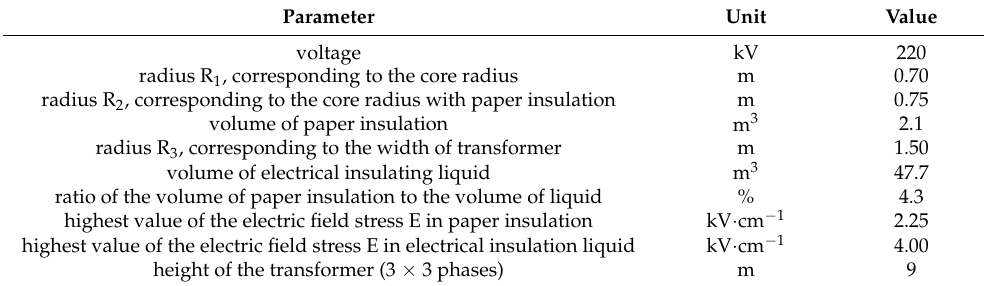
Table 2. Technical data of selected 220/110 kV transformers used to estimate dielectric losses [41].